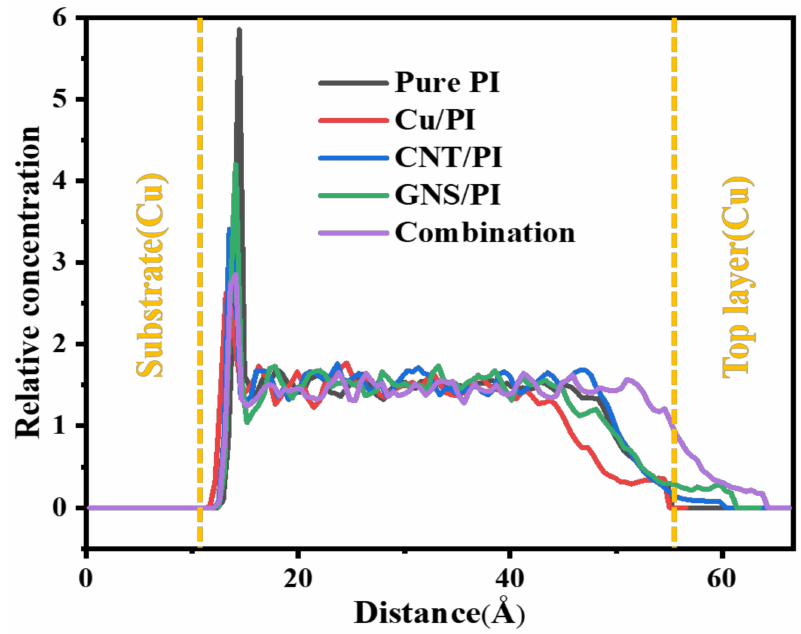
Figure 11. Concentration profiles of friction